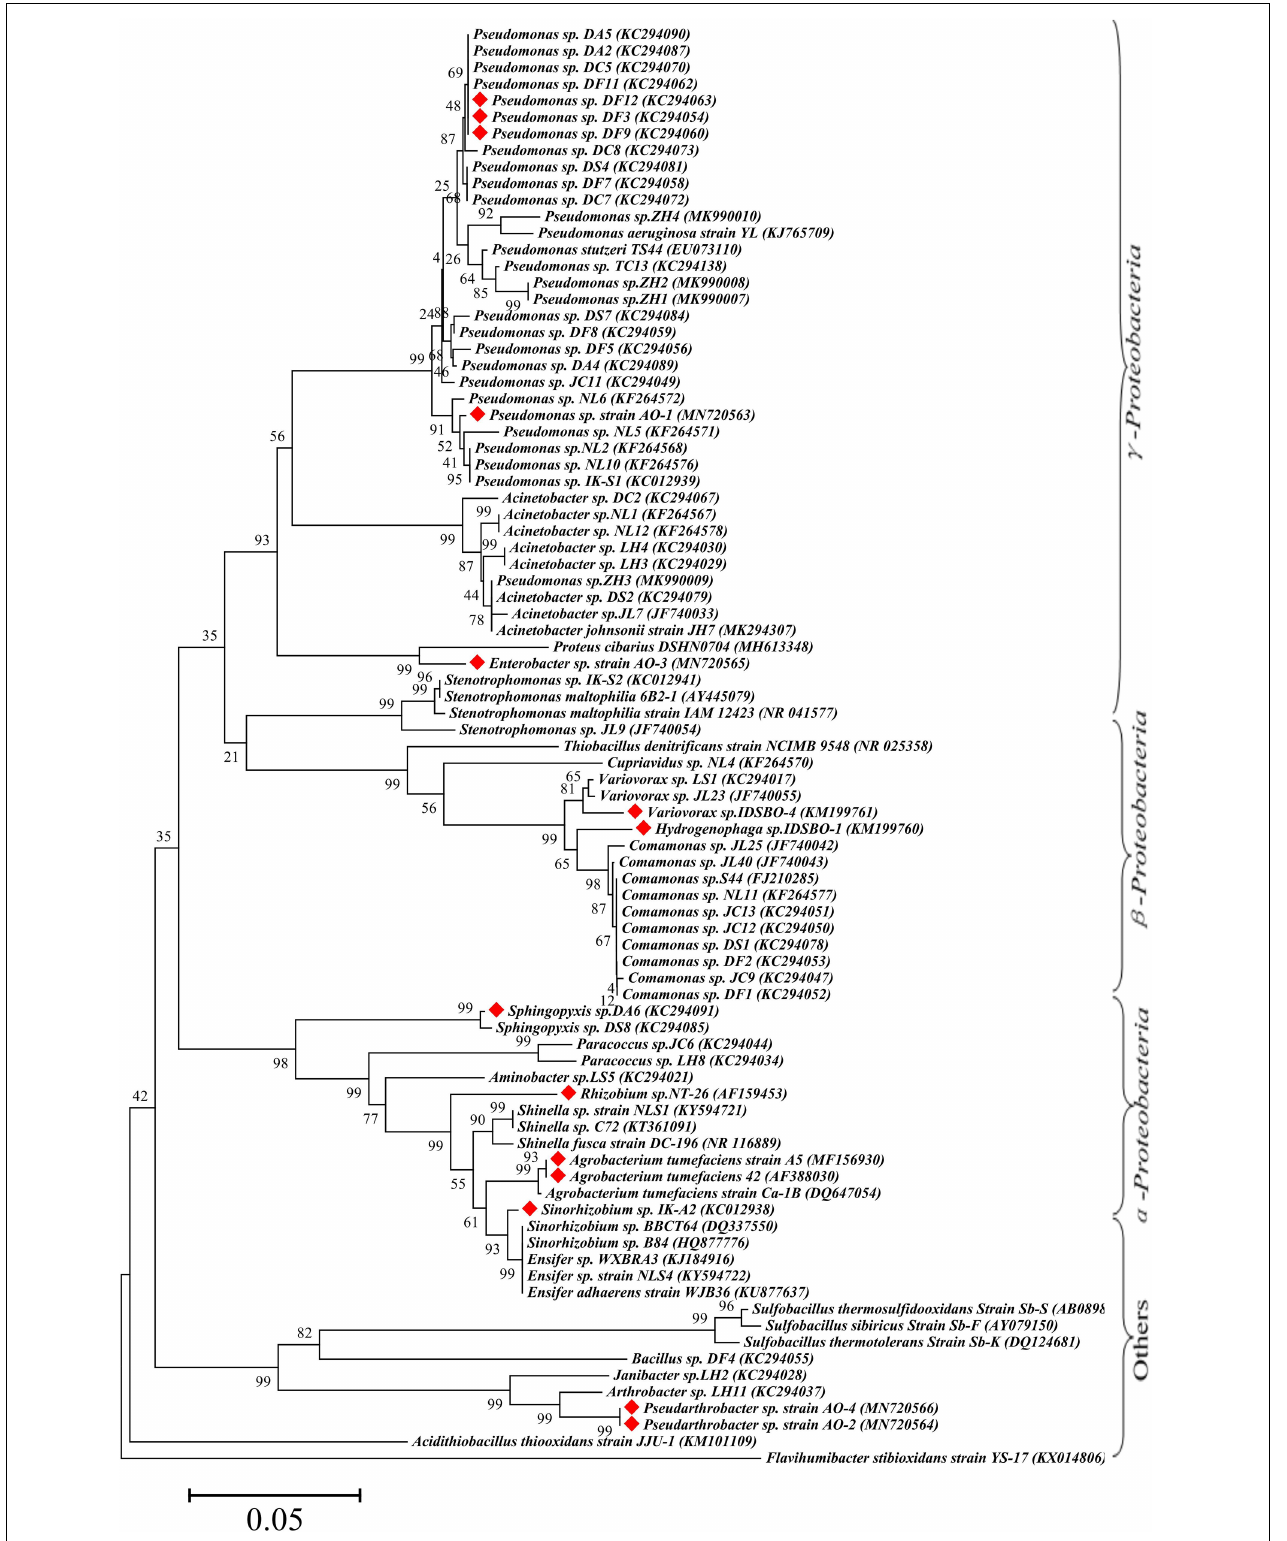
FIGURE 2 | Maximum-likelihood phylogenetic tree of 16S rRNA gene of Sb(III) oxidizers. The red marks represent Sb-oxidizing bacteria with antimony and As oxidation ability.